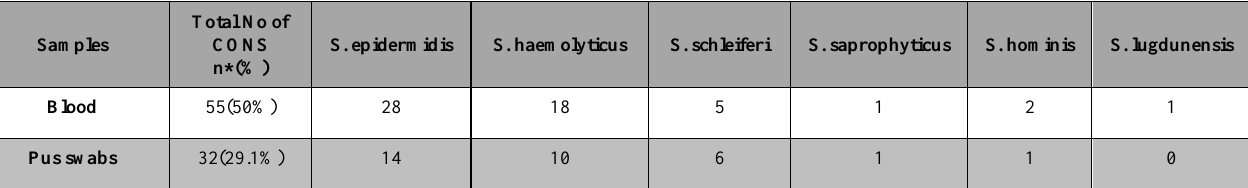
Table 2. Species distribution of CONS in various clinical